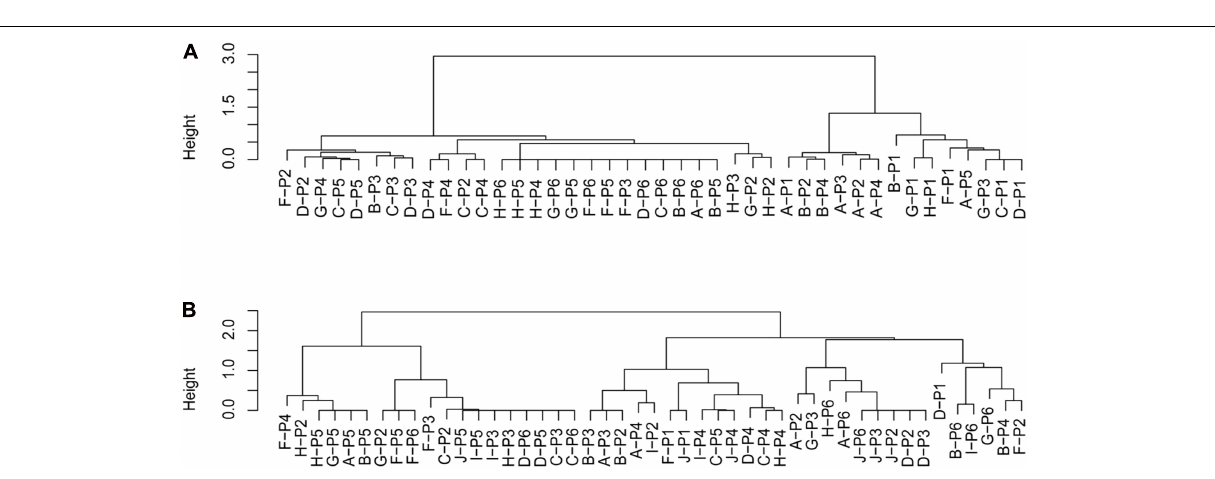
FIGURE 3 | The hierarchical clusters of duration of each action in each area before and after the alteration [ (A) dendrogram of before the alteration, (B) dendrogram of after the alteration]. The height, shown on the y -axis, means the similarity between action durations in the given area. The letters in dendrograms indicate each area (A, sandbox; B, slide; C, tires; D, open; F, woodstep; G, woodslope; H, tower; I, mound; and J,